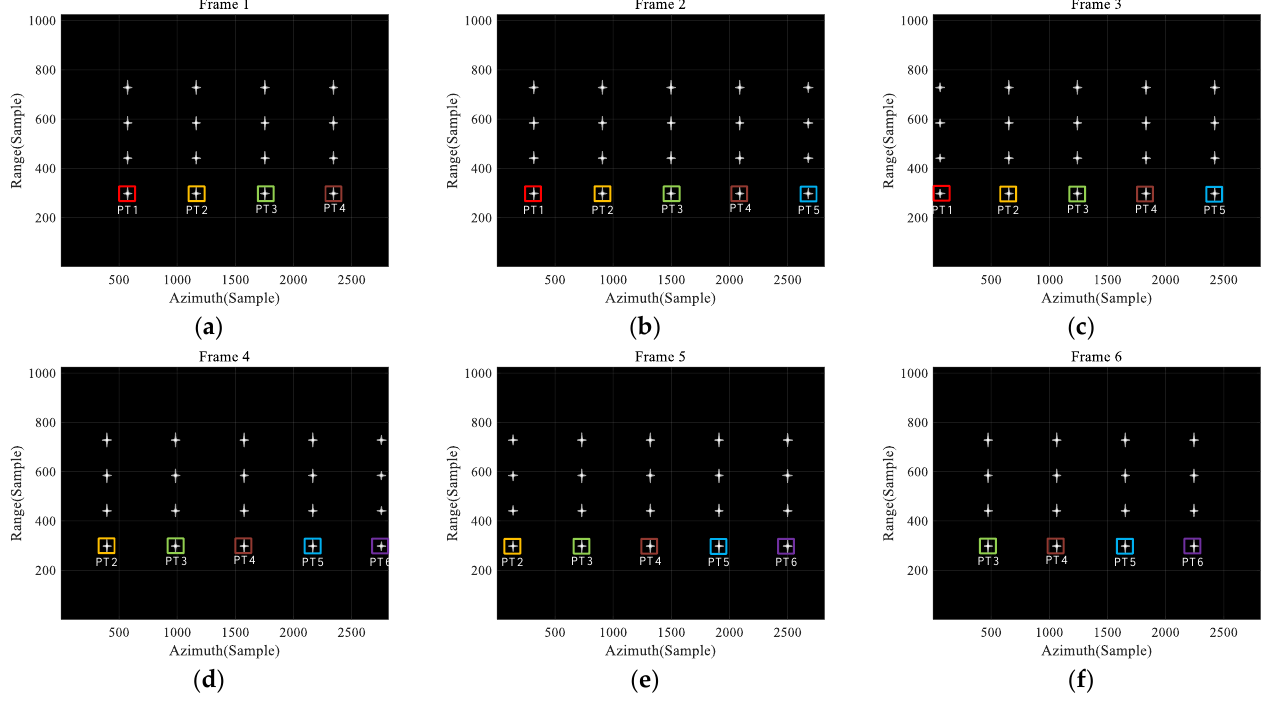
Figure 10. ViSAR simulation result. ( a ) First frame image; ( b ) Second frame image; ( c ) Third frame image; ( d ) Fourth frame image; ( e ) Fifth frame image; ( f ) Sixth frame image.